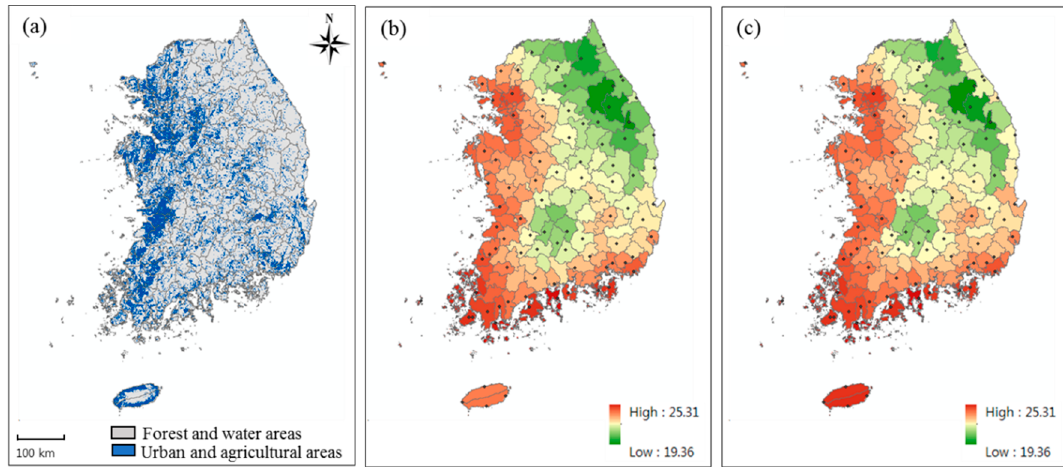
Figure 11. ( a ) Two types of land used for analyzing the temperature correlations at the screen level; ( b ) daily minimum temperature distribution of 167 administrative boundary units, based on all the grids (average of August 2018); and ( c ) daily minimum temperature distribution of 167 administrative boundary units based on urban and agricultural grids (average of August 2018). The black dots in ( b ) and ( c ) represent the 88 ASOS observation points.